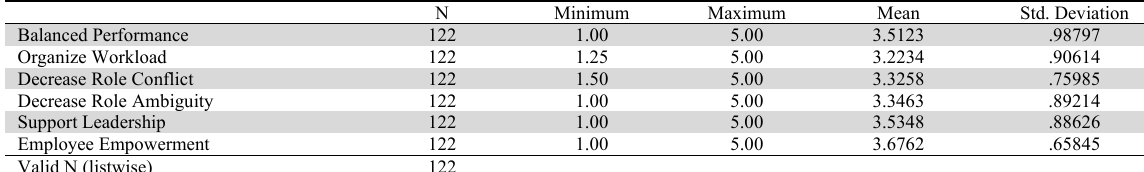
Descriptive statistics